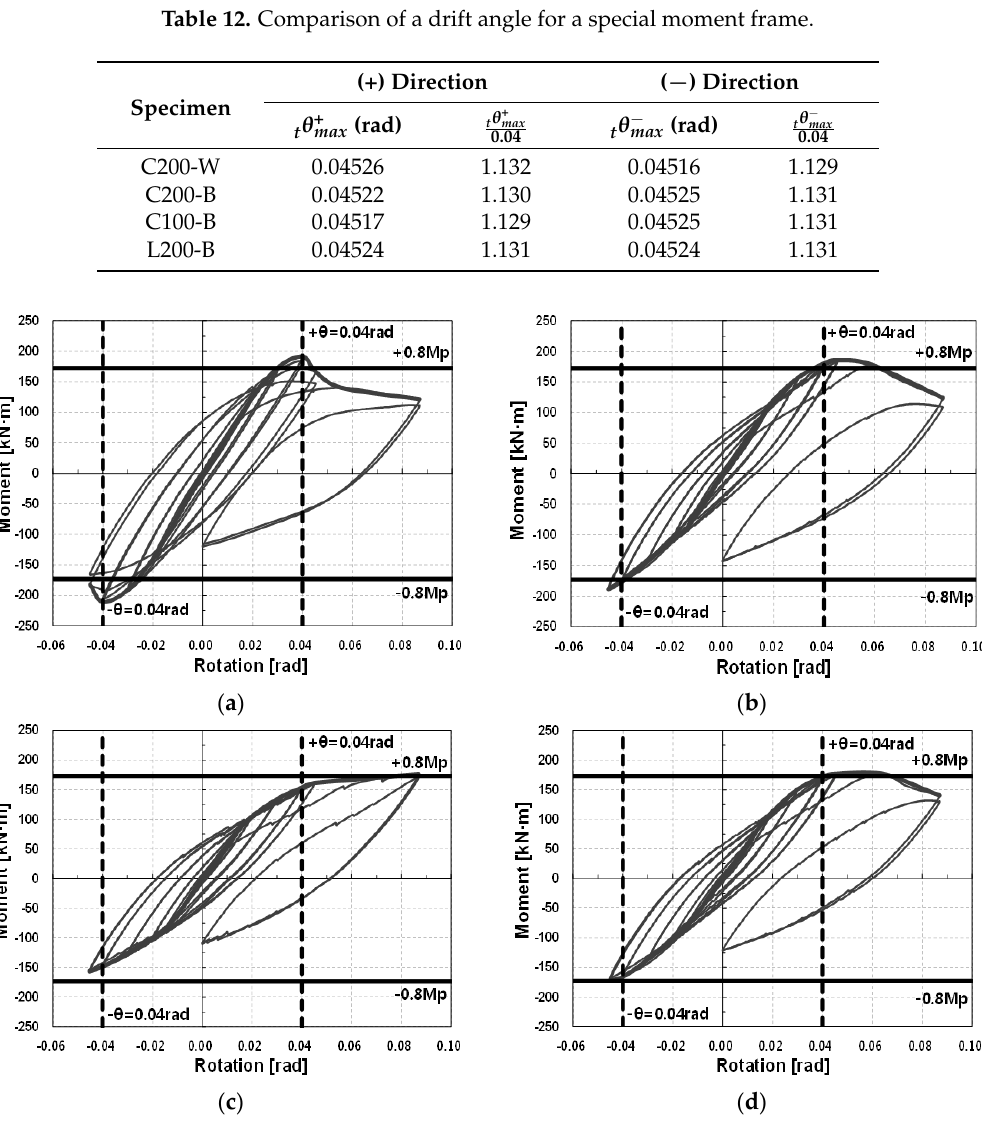
Figure 13. Seismic performance of the specimens: moment–rotation curves. ( a ) C200-W; ( b ) C200-B; ( c ) C100-B; ( d ) L200-B.